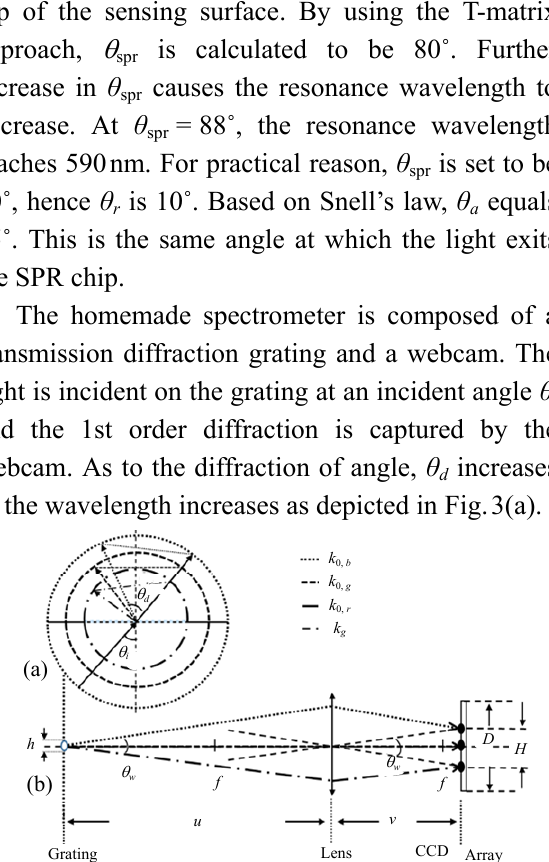
Fig. 3 Ray tracing for spectrometer design: (a) wave vector diagram used for computation of diffraction angles based on grating period and incident angle ( θ i ), ( k 0, b – round dot line, k 0 , g – squared dot line, k 0, r – long dash dot line) and (b) ray tracing demonstration of imaging